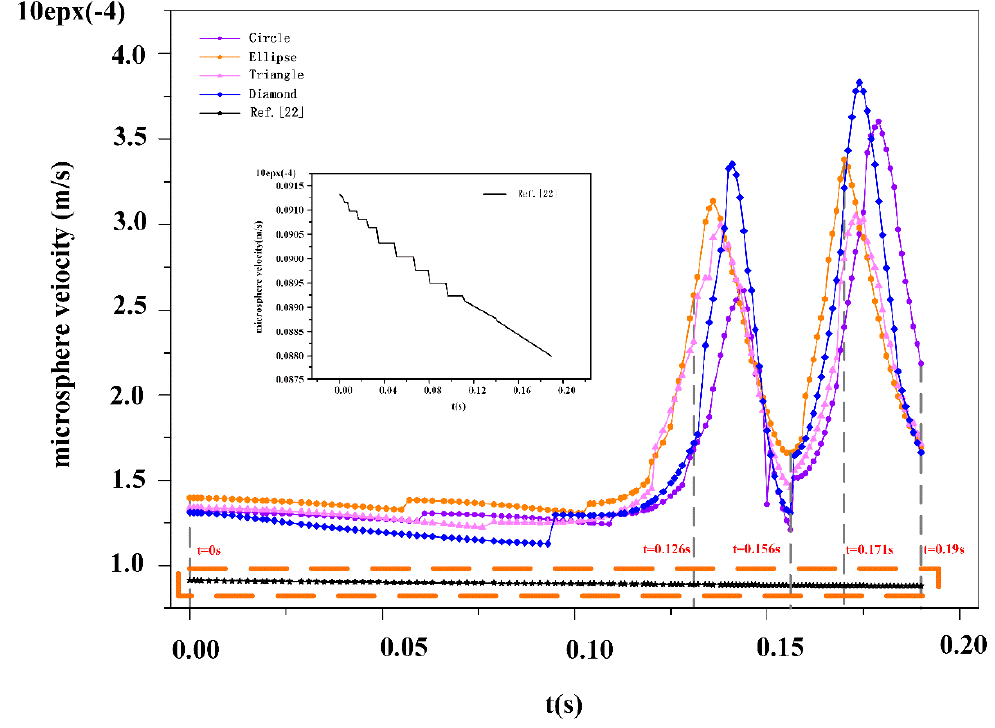
Figure 8. The velocity of the microspheres changes over time. Four kinds of microspheres with circular, elliptical, triangular, and diamond shapes were compared with the data of the reference [22], and a series of time points were selected to analyze their velocity: t = 0 s, 0126 s, 0.156 s, 0.171 s, and 0.19 s.